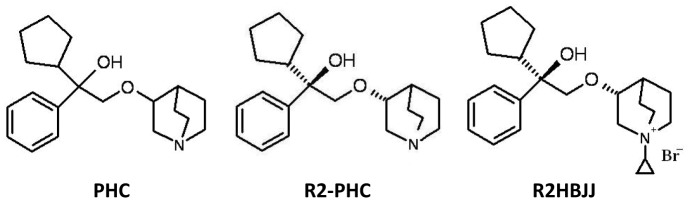
Structures of R2HBJJ and its parental compounds.